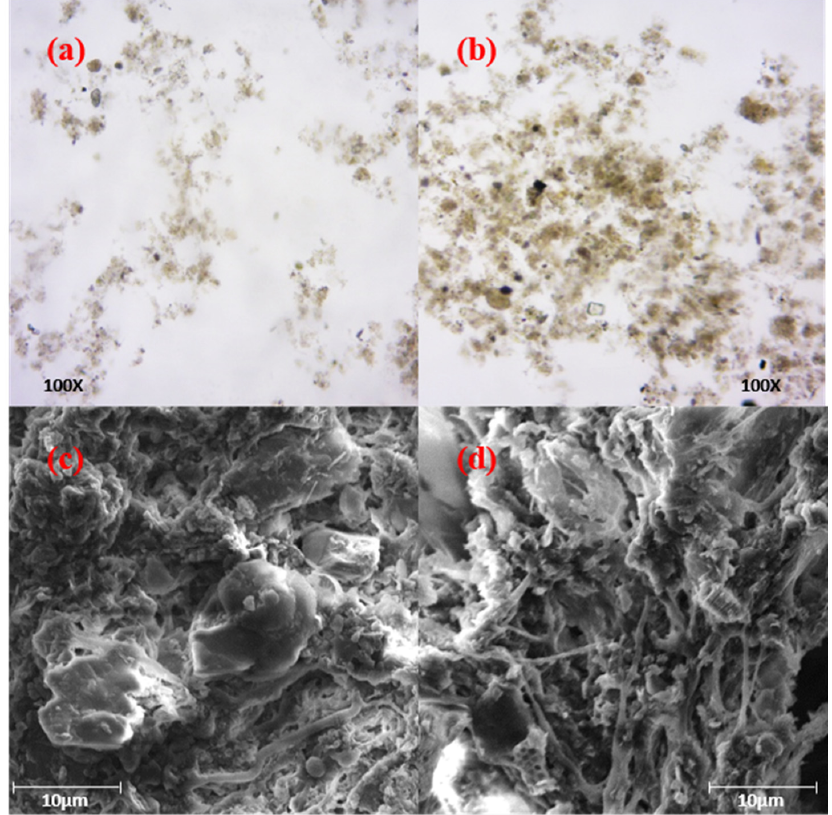
Figure 4. ( a ) An optical microscope image of raw sludge morphology (100 × ), ( b ) An optical micro- scope image of electrolyzed sludge morphology (100 × ), ( c ) A scanning electron micrograph (SEM) image of raw sludge morphology, and ( d ) An SEM image of electrolyzed sludge morphology.